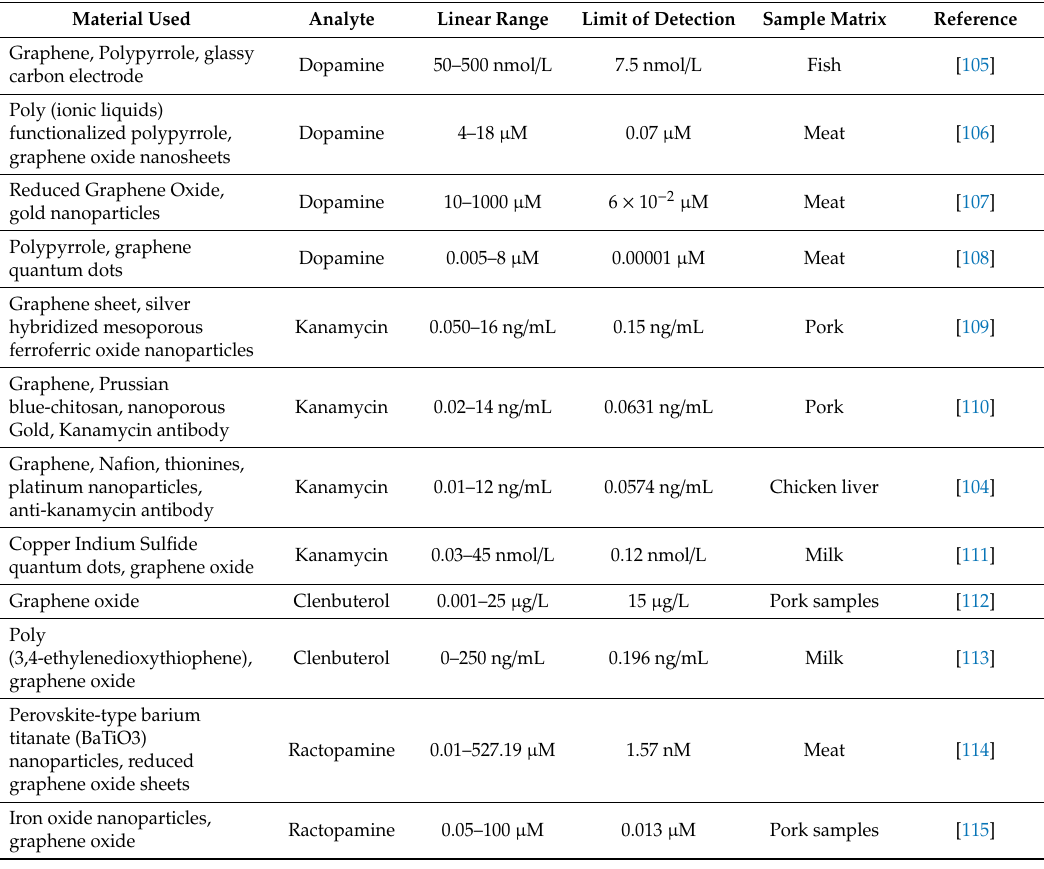
Table 3. Comparative study of the research work done on the detection of biomolecules in food using graphene-based sensing prototypes.